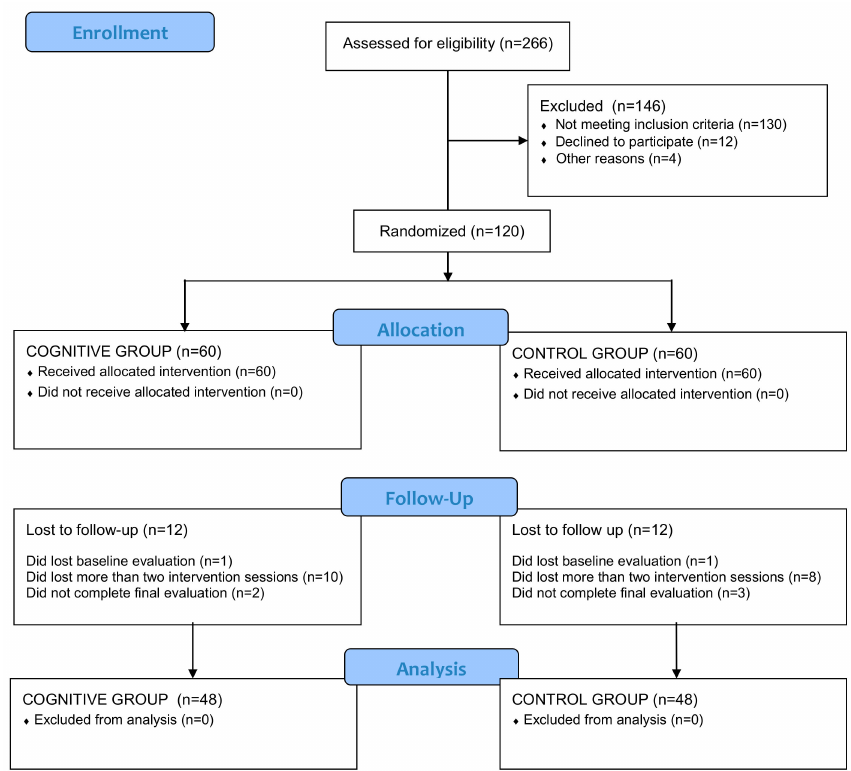
Figure 1. Flow diagram of the